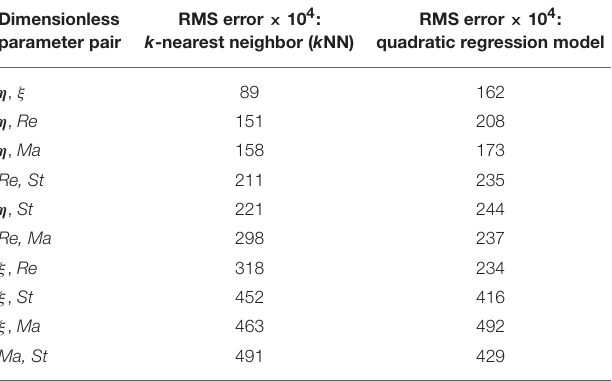
TABLE 2 | Ten-fold cross-validation errors resulting from of all ten possible pairings using the five dimensionless parameters resulting from dimensional analysis: η , ξ , Reynolds number ( Re ), Mach number ( Re ), and Strouhal number ( St ). Dimensionless RMS error × 10 4 : RMS error × 10 4 : k -nearest neighbor ( k NN) parameter pair quadratic regression